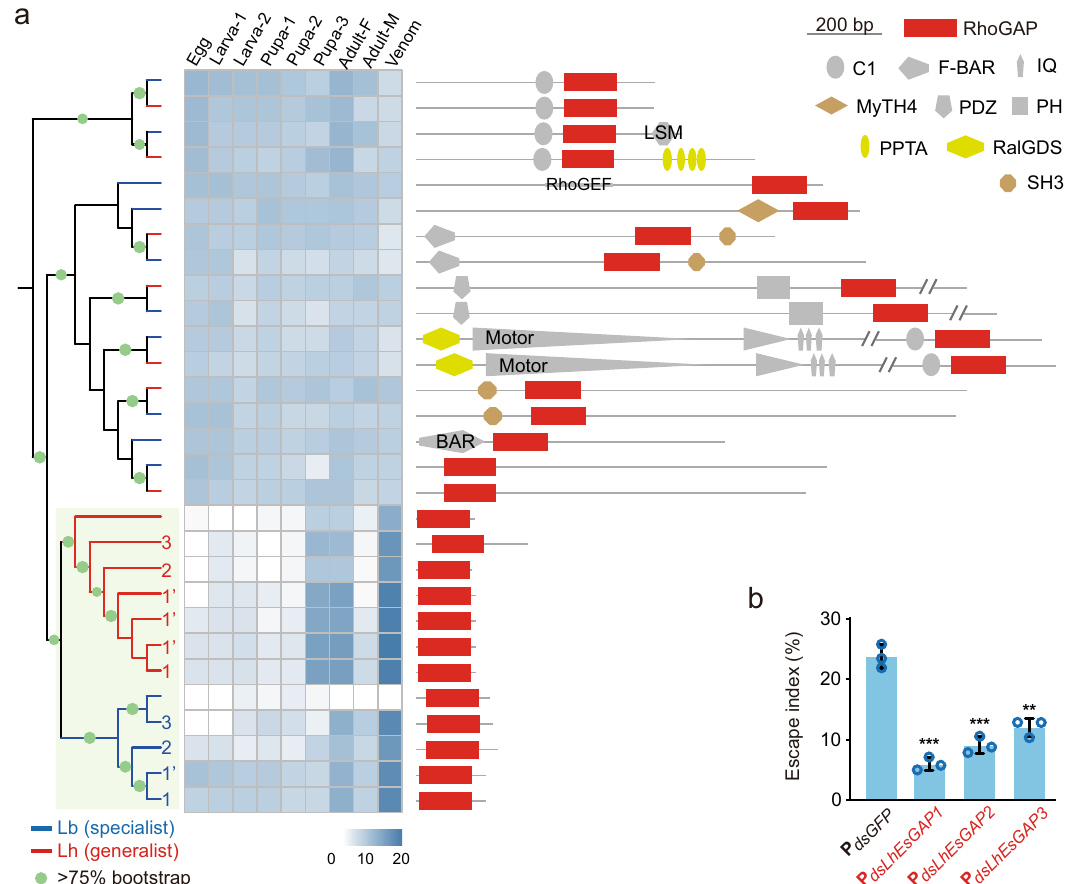
Fig. 5 Molecular evolution of RhoGAP-containing genes in Leptopilina . a Phylogenetic relationship across all potential RhoGAP domains encoded in Lh and Lb genomes. Branches being followed with a number indicate the corresponding termed EsGAP genes with functional evidence. Note that there are tandem duplicated copies of EsGAP1 in both Lb and Lh, which share the near-identical sequence with EsGAP1 and therefore are termed as LbEsGAP1 ’ and LhEsGAP1 ’ , respectively. The expression pro fi le of each locus is shown in the heatmap. The actual gene length is indicated by the line and schematic gene architecture is shown with annotated domains. See detailed information in Supplementary Table 3. b Escape indices of host ( D. melanogaster ) that were parasitized by dsRNA -treated Lh. LhEsGAP1 , LhOGS01638; LhEsGAP2 , LhOGS20221; LhEsGAP3 , LhOGS01640. dsGFP -treated Lb (P dsGFP ) was used as a control. The number of larvae exhibiting escape behaviour was recorded from 30 min to 75 min after exposure to Lh. Left to right: n = 424, 357, 341 and 355 biologically independent host larvae. Three biological replicates were performed. Data are presented as mean values± SD. Signi fi cance was determined by two-sided unpaired Student ’ s t test (P dsLhEsGAP1 : P = 0.0002; P dsLhEsGAP2 : P = 0.0004; P dsLhEsGAP3 : P = 0.0011; ** P < 0.01; *** P < 0.001). Source data are provided as a Source data fi